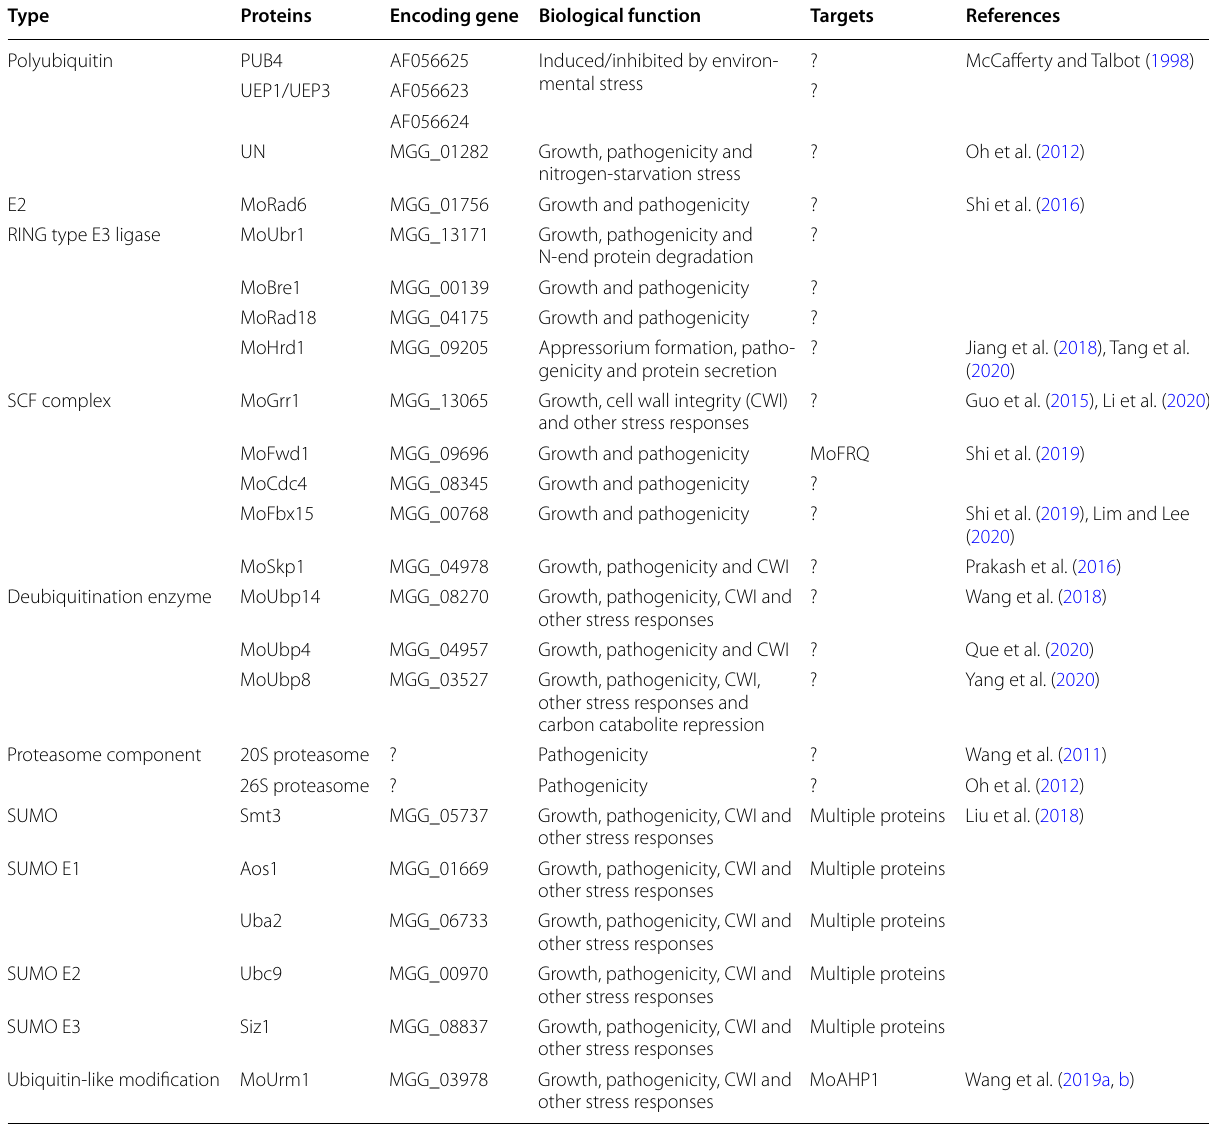
Table 1 Ubiquitin pathway‑associated proteins in M. oryzae